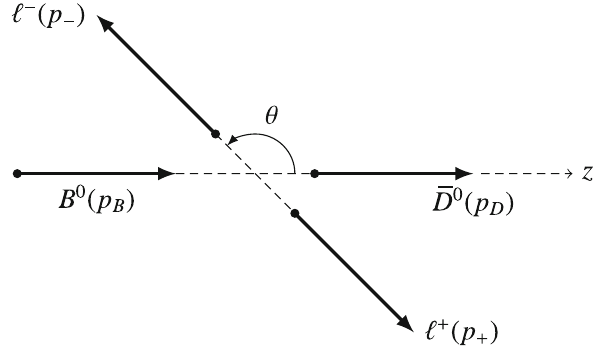
Fig. 1 Decay of B 0 → D 0 (cid:2) + (cid:2) − in the Gottfried–Jackson